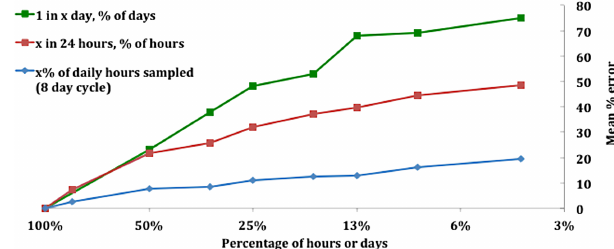
Figure A2. Relative errors representing annual mean PM 2 . 5 ob- tained from 100 EPA sites averaged over various hourly periods for 2006. Sampling periods are divided into (a) 1-in- x ( x = 1 to 24) day sampling intervals (green squares), (b) fraction of day (1 to 24h per day, red squares), and (c) staggering x % of hours per day during an 8day cycle (blue